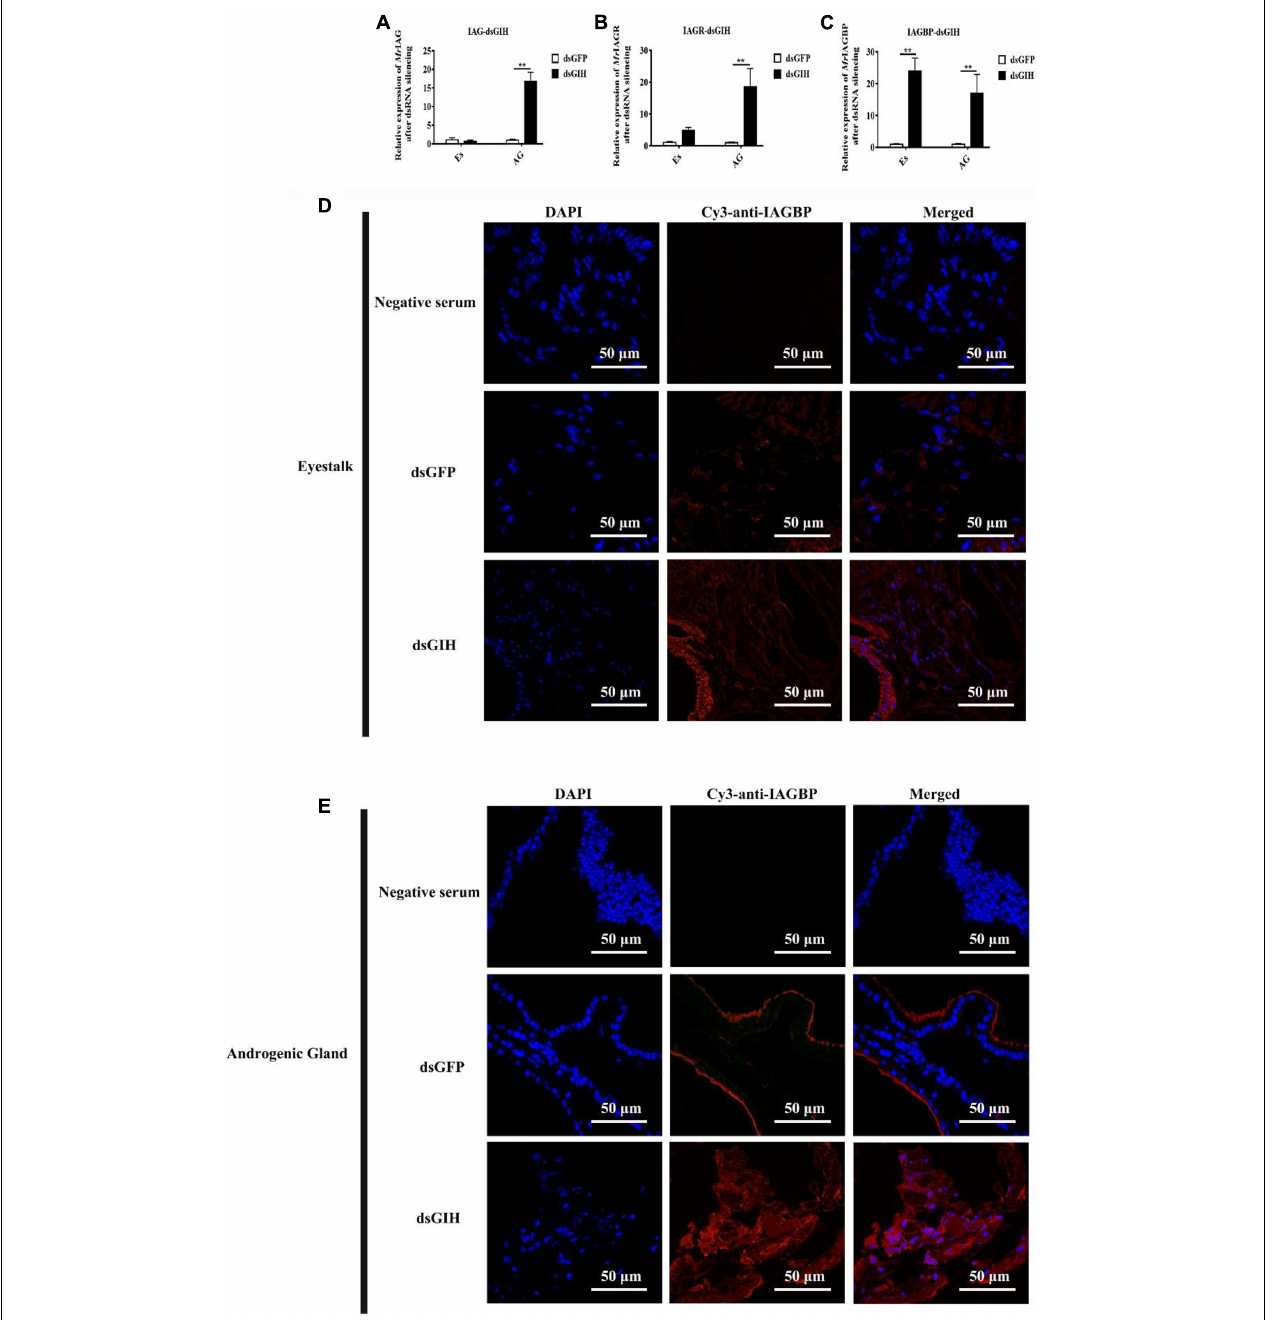
FIGURE 7 | Effects of ds RNA- Mr GIH injection. The mRNA expression levels of Mr IAG (A) , Mr IAGR (B) , and Mr IAGBP (C) in eyestalk (Es) and androgenic gland (AG) after Mr GIH knockdown at 24 h. ds GFP, injected with ds GFP RNA; ds GIH, injected with ds GIH RNA. The protein expression levels of Mr IAGBP in the eyestalk (D) and androgenic gland (E) after injected with dsMr GIH at 24 h. Mr IAGBP was in red fluorescence signals. Negative serum served was as the control. Scale bar was indicated 50 µ m. ** P < 0.001.